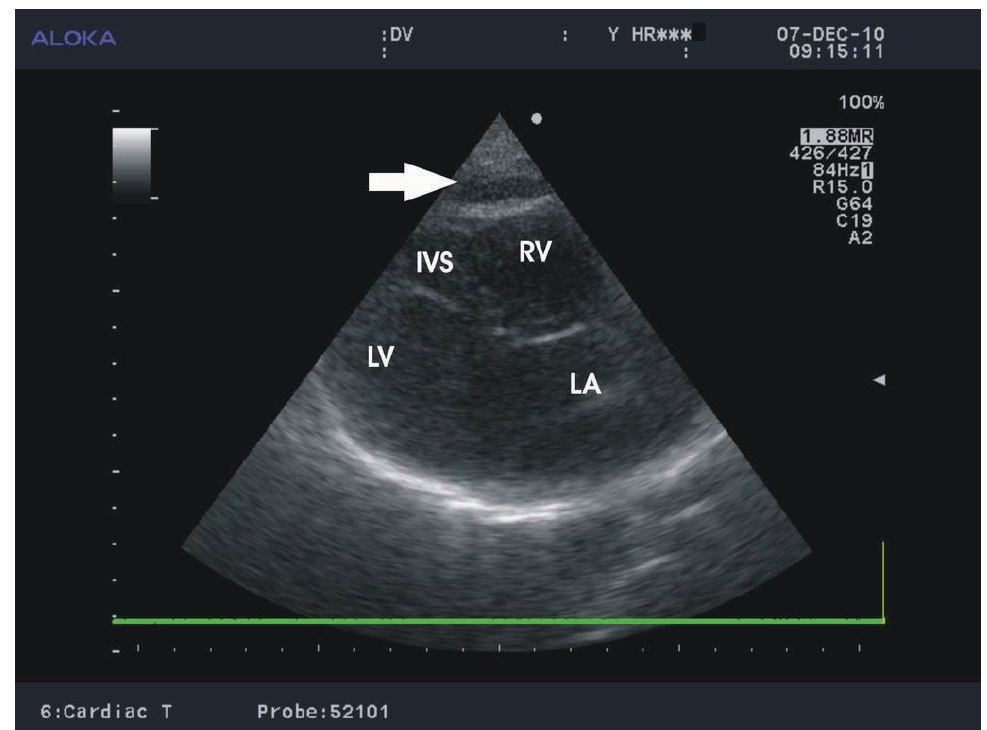
Figure 2. Transthoracic echocardiogram in the parasternal long axis view at the end of the systole, showing an echo-free area on the free wall of the right ventricle representing the epicardial fat. LA = left atrium; LV = left ventricle; IVS = interventricular septum; white arrow = epicardial adipose